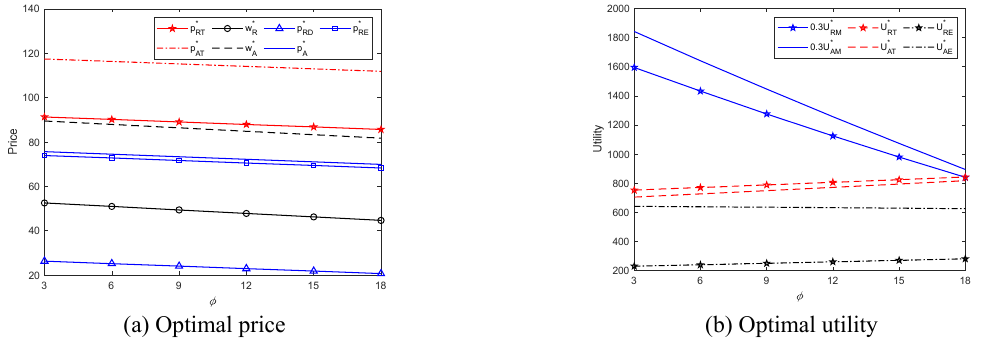
Fig. 7. Impact of risk aversion on optimal price and optimal